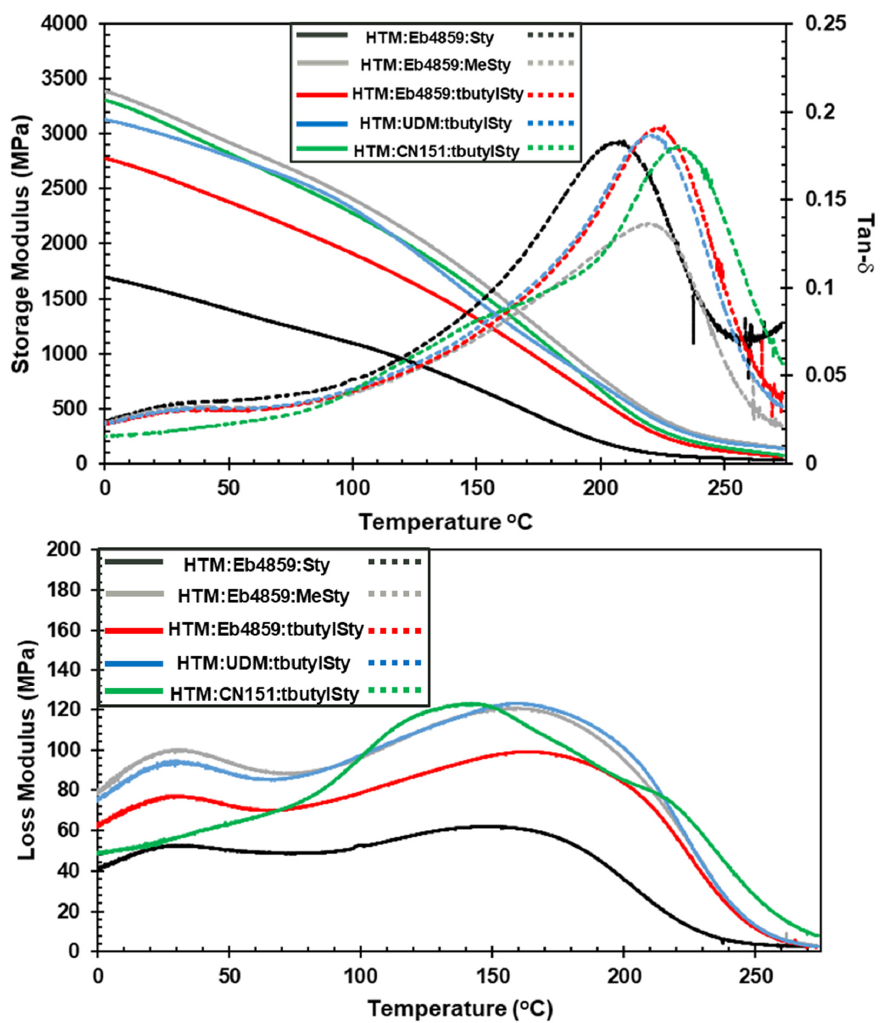
Figure 11. Thermomechanical data of 3D printed HTM thermosets. All formulations have mass ra- tios as follows HTM:crosslinker:diluent (2:1:2). Top: Storage modulus and Tan- δ ; bottom: loss mod- ulus.